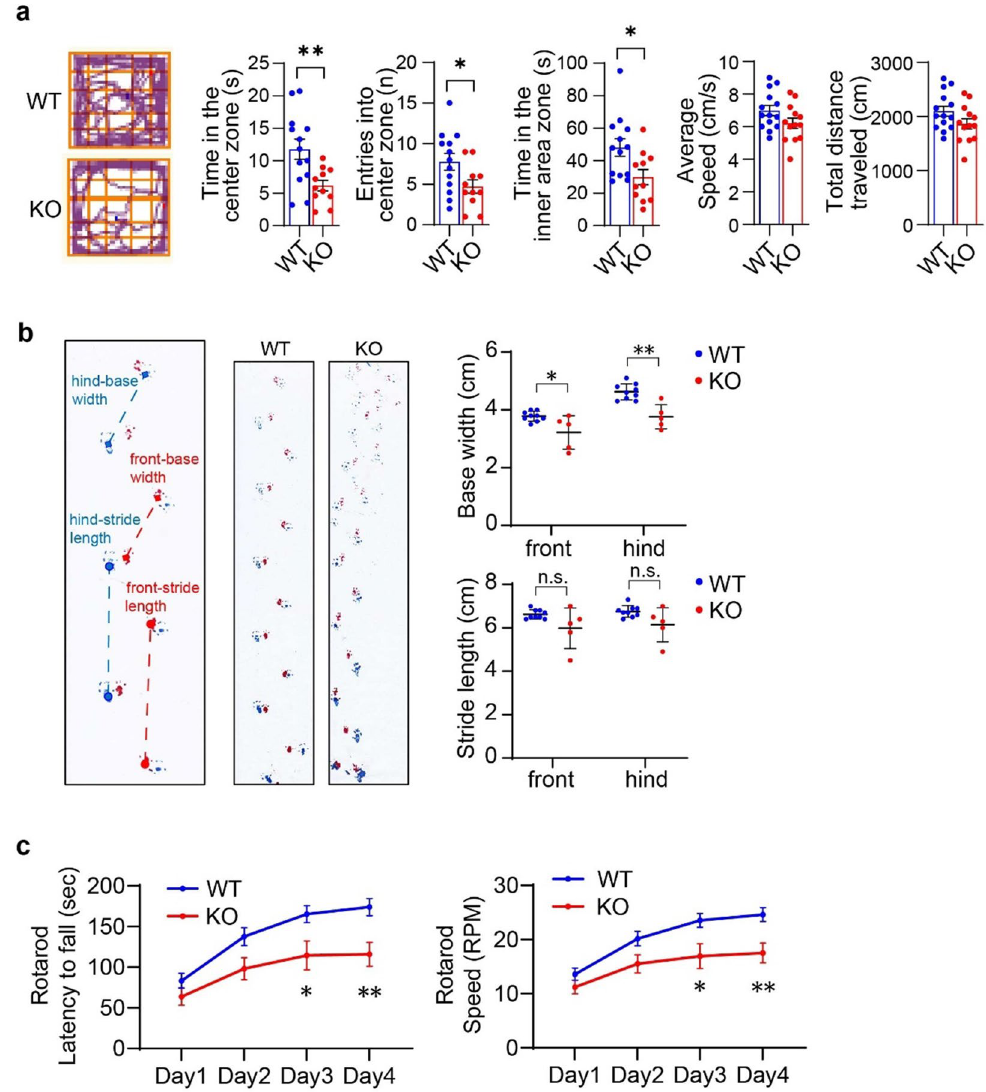
Figure 3. Adult Zfp212-KO mice show aberrant locomotion. ( a ) Open-field test of 3-month-old Zfp212-WT and -KO mice (WT; n = 13, KO; n = 9). Movement of mice was tracked and analyzed with EthoVision XT software (https:// www. noldus. com/ ethov ision- xt). ( b ) Gait analysis of 3-month-old Zfp212-WT and -KO mice (WT, n = 9; KO, n = 5). n.s., not significant. ( c ) Rotarod test of 3-month-old Zfp212-WT and -KO mice (WT; n = 13, KO; n =